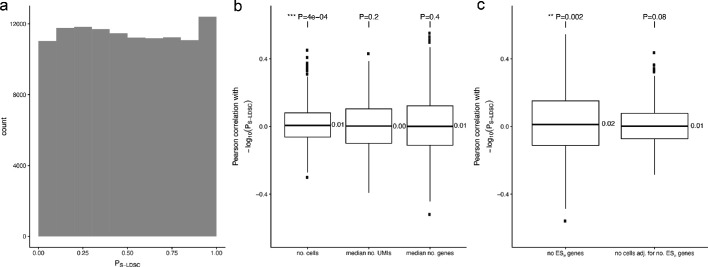
Tests for confounding factors.(a) Histogram of S-LDSC p-values for 115 cell types in the Tabula Muris dataset across 1000 null GWAS. The modest enrichment near one and depletion near 0 may be due to imperfect calibration of the S-LDSC method. (b) Pearson correlation coefficients between S-LDSC p-values and the number of cells, median number of UMIs and median number of genes expressed, respectively, for 115 Tabula Muris cell types, computed for 1000 null GWAS. The leftmost boxplot shows a small but statistically significant mean correlation between cell cluster sizes and S-LDSC p-values. (c) Pearson correlation coefficients between S-LDSC p-values and, respectively, number of ESμ genes and number of cells adjusted for number of ESμ genes, over 115 Tabula Muris cell types, computed for 1000 null GWAS. The small mean correlation between cell numbers and CELLECT S-LDSC p-values was no longer statistically significant after accounting for the number of ESμ genes.